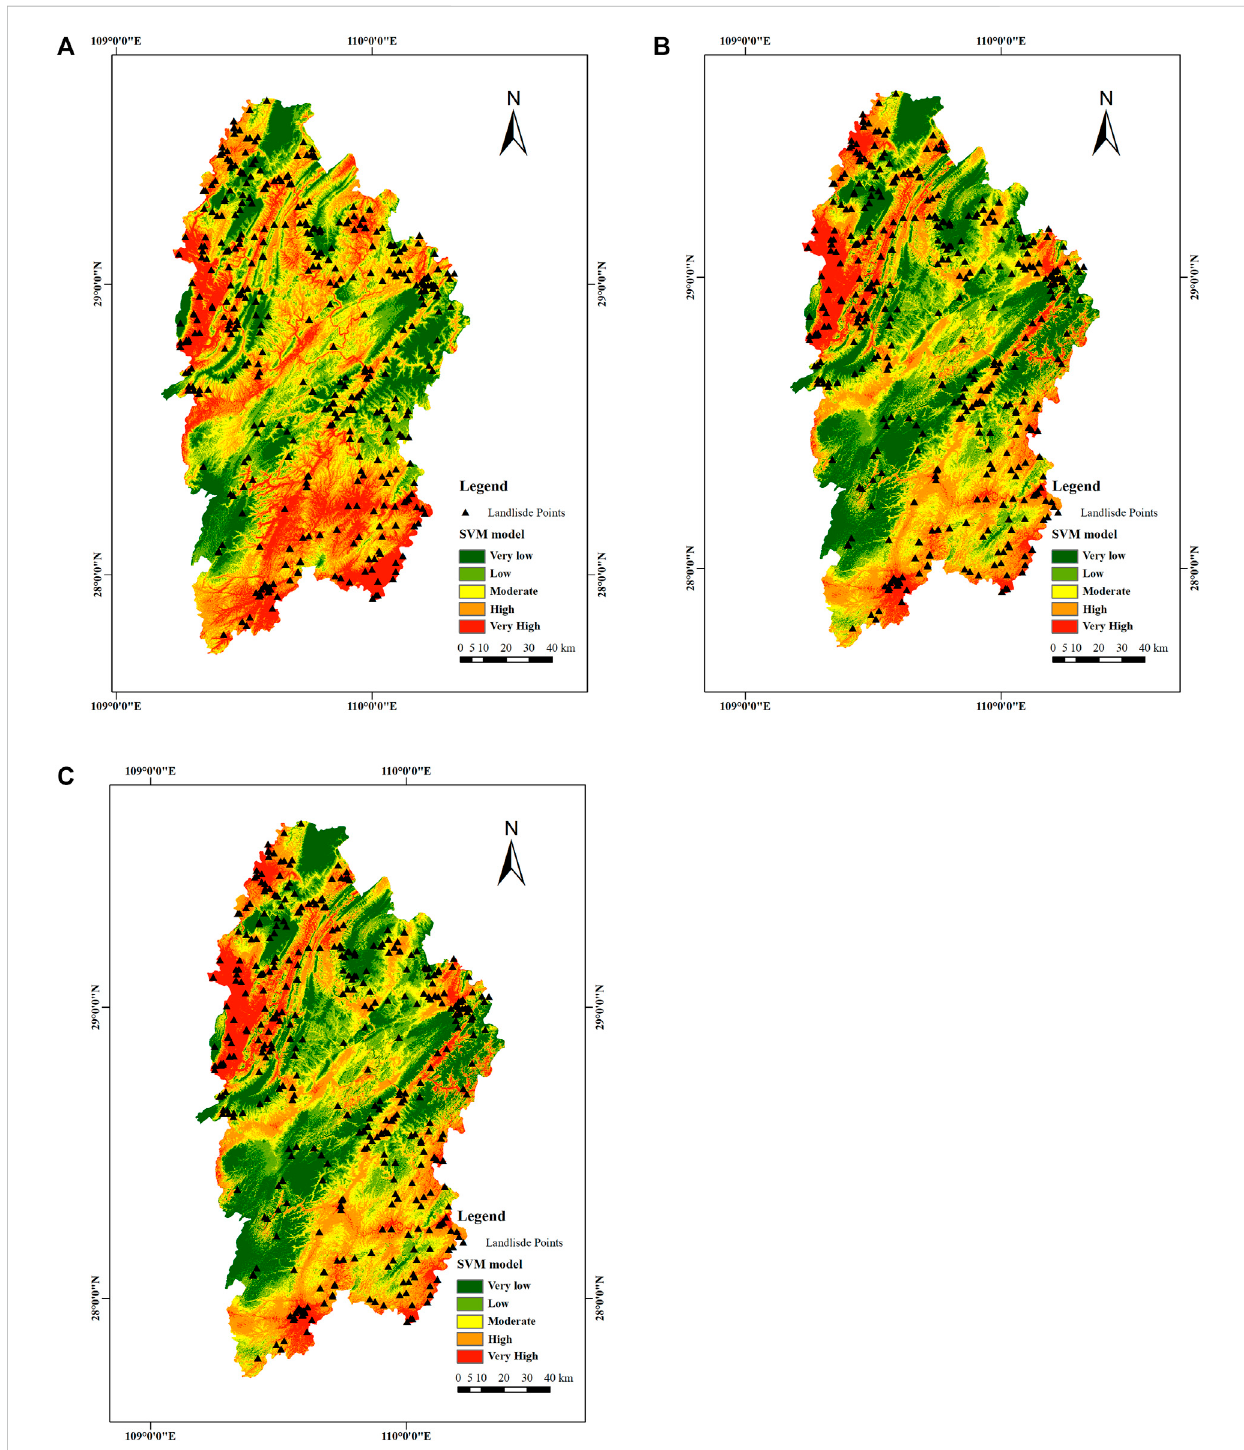
FIGURE 8 Evaluation results of landslide susceptibility mapping. (A) LSM of the SVM model; (B) LSM of the CNN model; (C) LSM of the 3DCNN